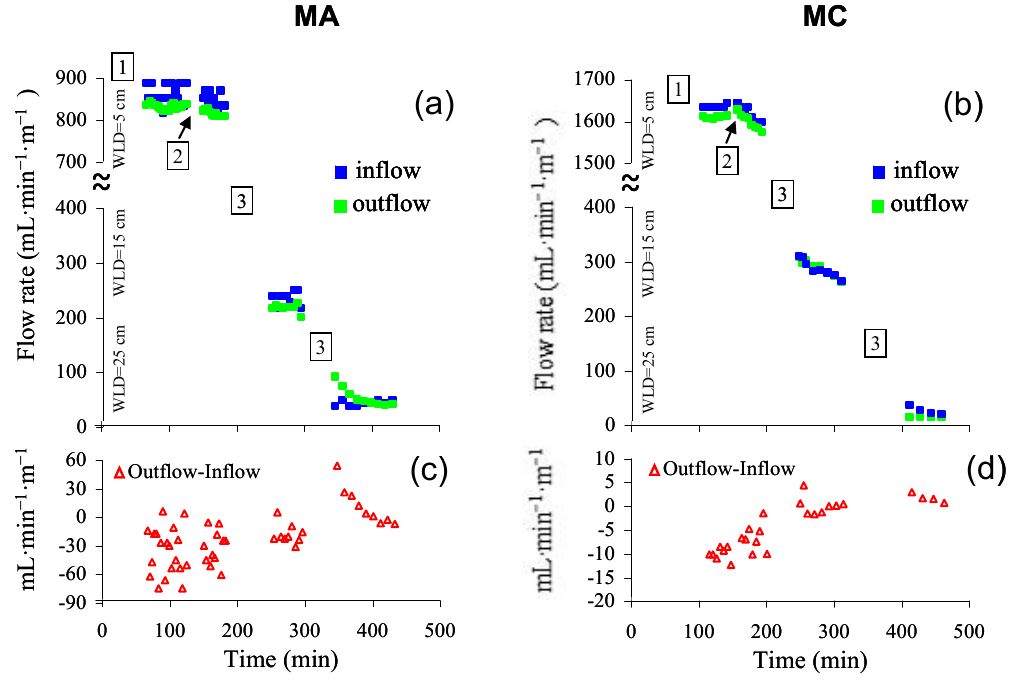
Figure 3. ( a , b ) Time series of the inflow and outflow rates measured during the experiments in the soil monoliths MA and MC; ( c , d ) computed differences between outflows and inflows. Note the difference in flow rate scale in the graphics. Numbers in squares indicate the following experiment stages: (1) soil saturation; (2) Mariotte bottle refilling; (3) water-level depth transition.